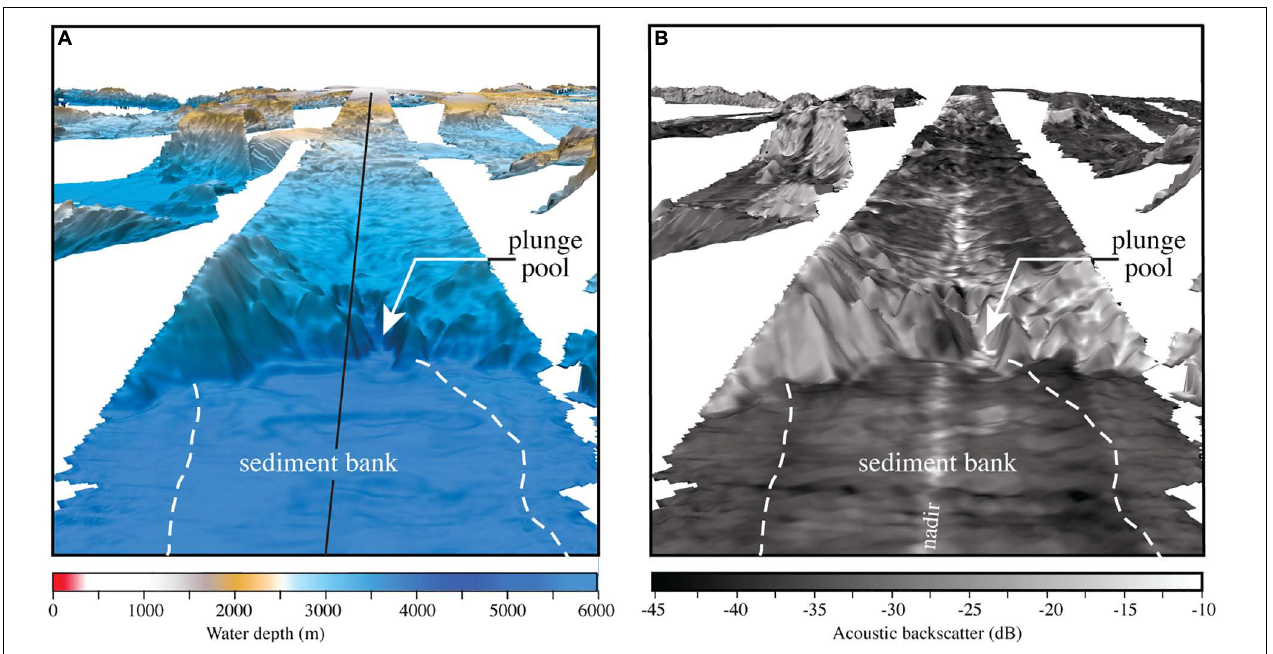
FIGURE 6 | Perspective view of the bathymetry (A) and acoustic backscatter (B) of the plunge pool and sediment bank of channel system CS-A. Vertical exaggeration 5 × . Note large difference in backscatter between the high backscatter of the flank of the NLIR escarpment and the low backscatter of the sediment bank. The sediment bank has a volume of > 9.25 km 3 . Black line is track of subbottom seismic line L483 shown in profile A–B (see Figure 8 ).